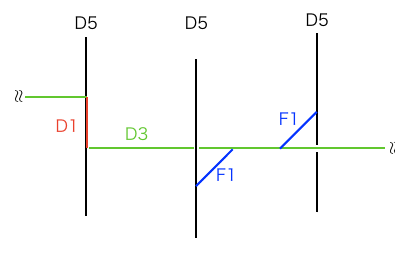
Figure 11 . The root of Higgs branch.